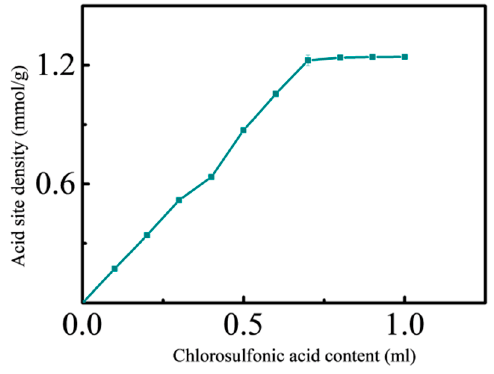
Figure 2. E ff ect of the amount of chlorosulfonic acid on acid Figure 2. Effect of the amount of chlorosulfonic acid on acid density.